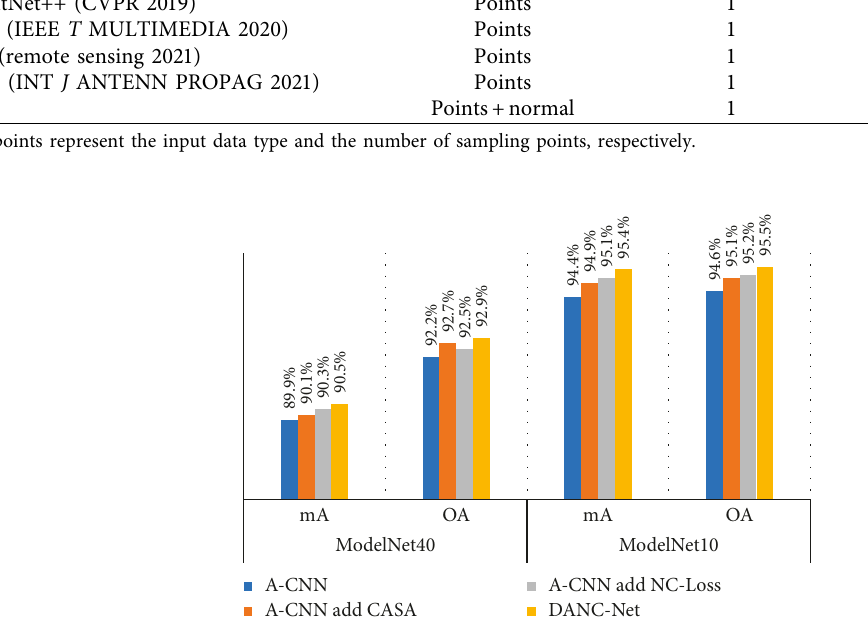
Figure 5: Classification effects of ablation experiments.